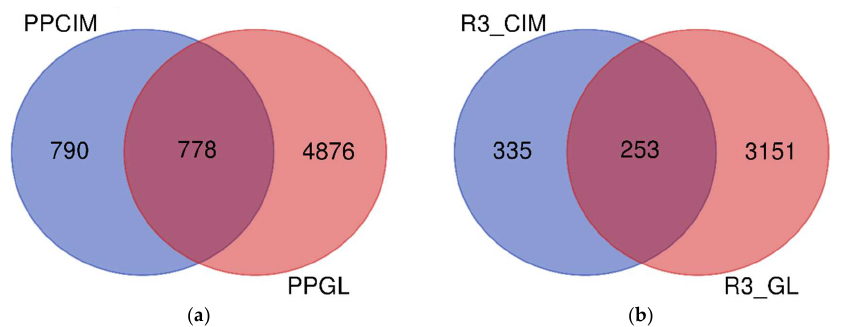
Figure 2. Venn diagram of the proteins identified with MaxQuant freeware in the cement and gland proteome of the barnacle P. pollicipes . Unique and shared proteins between ( a ) all proteins identified in the cement (PPCIM) and gland proteome (PPGL); and ( b ) all proteins identified in the three biological replicates of the cement (R3_CIM) and gland proteome